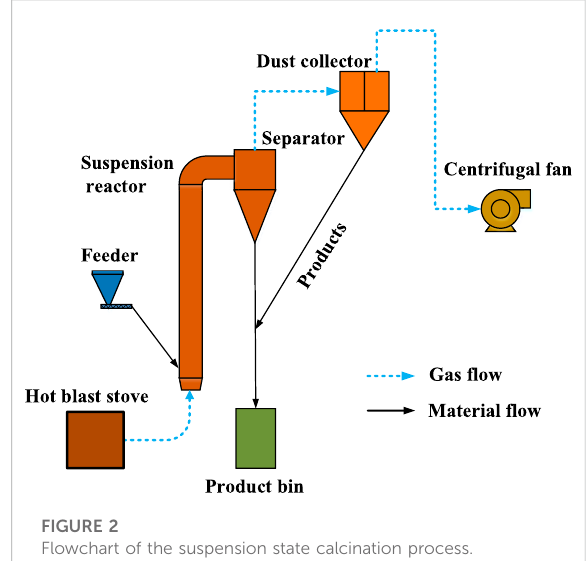
FIGURE 2 Flowchart of the suspension state calcination